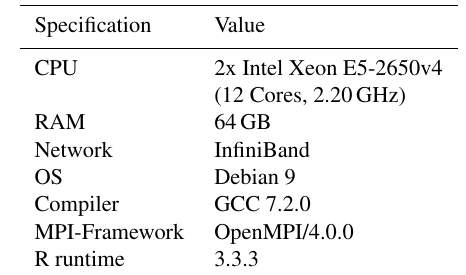
Table 2. Hardware and software specifications for the HPC test en- vironment “Turing”.